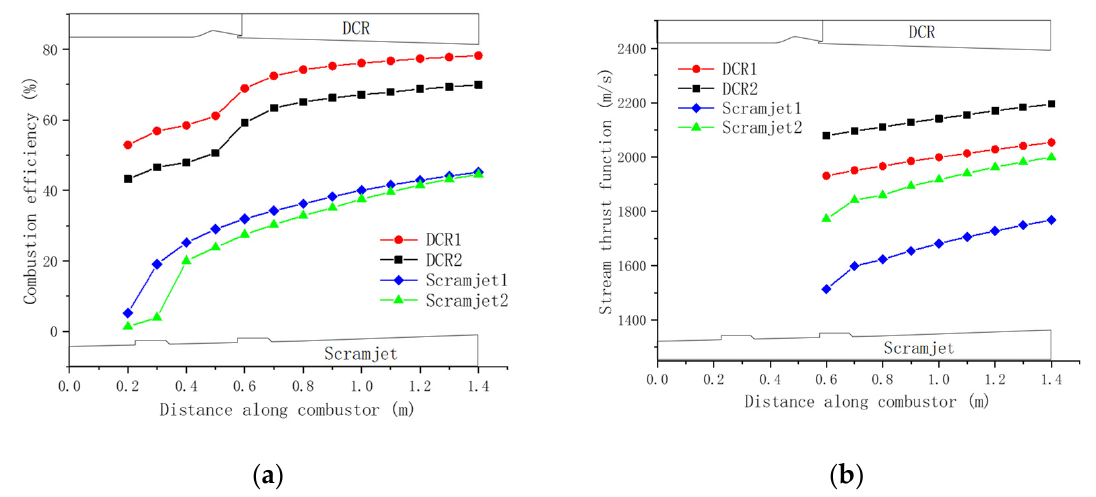
Figure 15. Curves for ( a ) combustion efficiency and ( b ) stream thrust function.